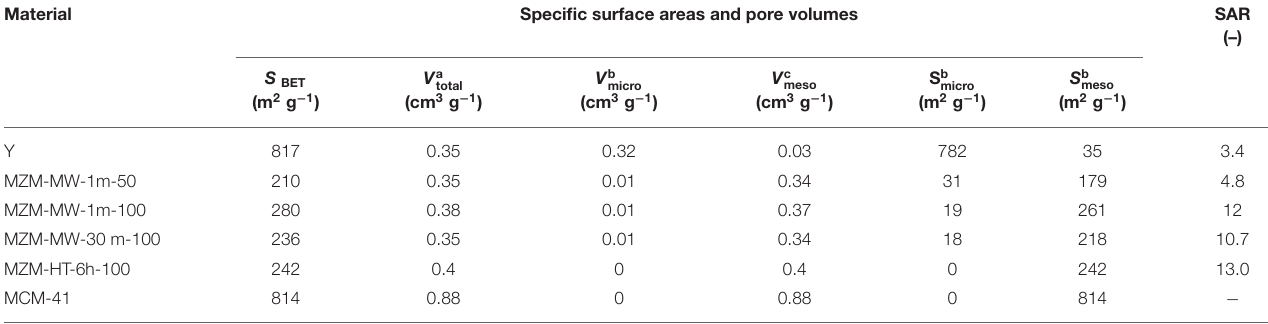
TABLE 1 | Textural properties and silicon-to-aluminum ratio (SAR) of materials. Material Specific surface areas and pore